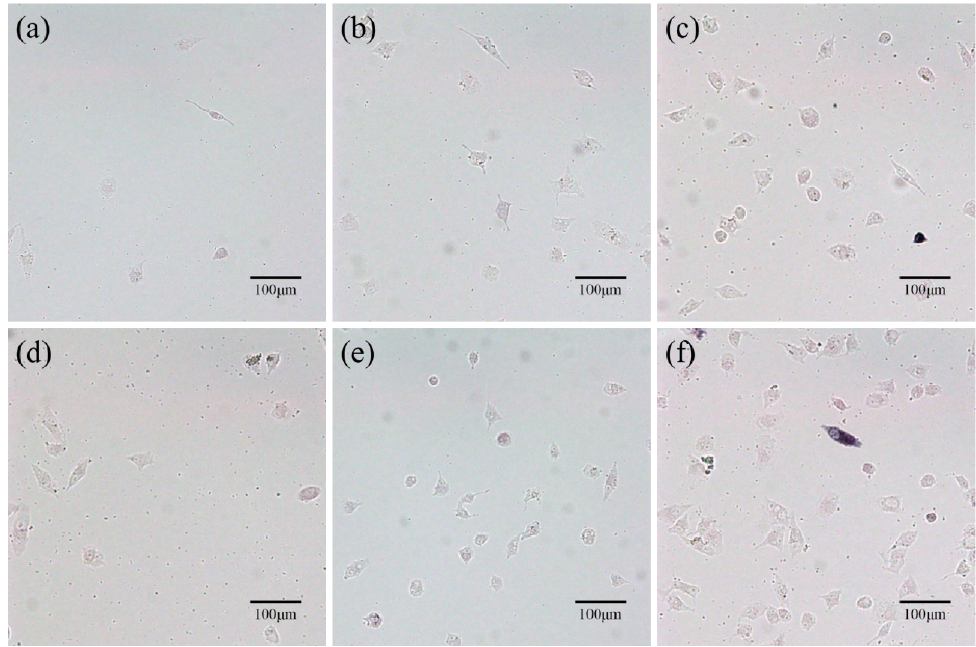
Figure 10. Osteogenic differentiation of MG63 cells cultured on the ( a – c ) PHBV scaffolds and ( d – f ) PHBV/10% composite scaffolds for ( a , d ) 1, ( b , e ) 4, and ( c , f ) 7 days. ALP (alkaline phosphatase) activity increased with the increase in culture time and the ALP activity for PHBV/10% composite scaffolds was higher than that for PHBV scaffolds at the same time point.